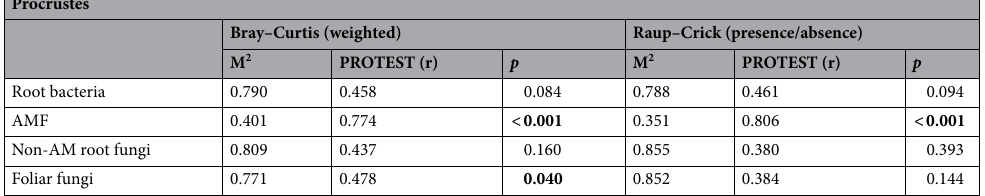
Table 3. Results of Procrustes analyses comparing two sampling strategies used to sample microorganisms colonizing A. speciosa roots and foliar tissue. Procrustes analyses were performed on Bray–Curtis distances of Hellinger transformed SV (sequence variant) relative abundances as well as on Raup–Crick distances of presence/absence data. Significant values are highlighted in bold. M 2 values represent the sum of squared deviations between sample pairs, where lower values mean a better fit between